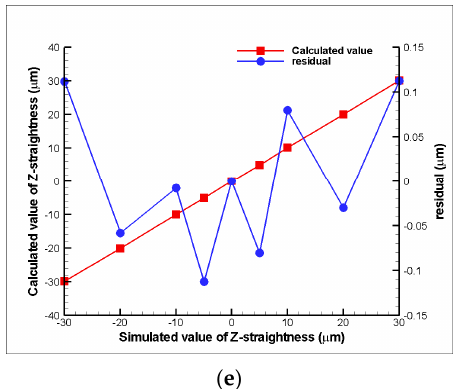
Figure 9. Verification of the mathematical model: ( a ) pitch, ( b ) roll, ( c ) yaw, ( d ) horizontal straightness, and ( e ) vertical straightness, respectively.